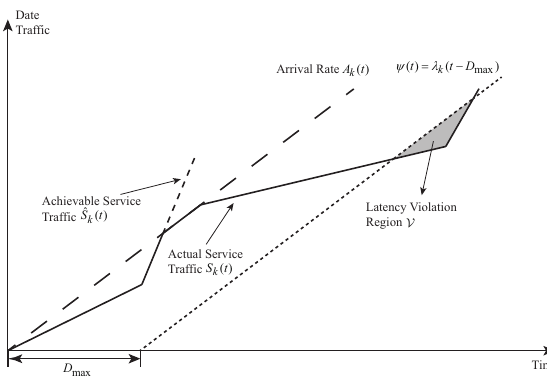
Figure 3. Traffic and service